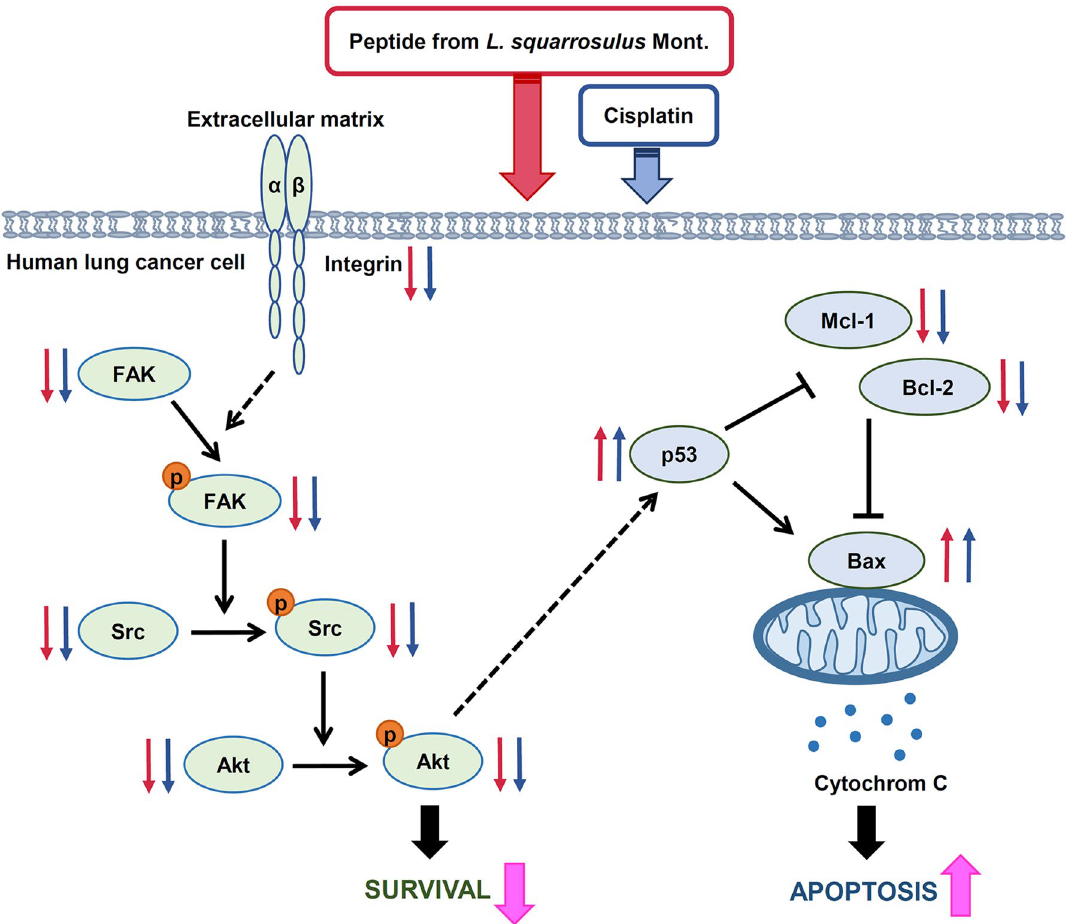
Figure 8. Proposed regulatory machinery of chemosensitizing effect of peptide extracted from Lentinus squarrosulus on cisplatin-induced apoptosis in human lung cancer cells. The peptide enhances the suppressive activity of cisplatin on integrin-mediating survival which resultes in the downregulation of integrin and down- stream signaling proteins including p-FAK/FAK, p-Src/Src and p-Akt/Akt as well as activation of apoptosis mediated by overexpression of p53 which correlates with increased Bax and diminution of anti-apoptosis Mcl-1 and Bcl-2 proteins. The effects of the peptide and cisplatin at non-toxic concentrations is indicated by red and blue small arrows, respectively. Big pink arrows represent the augmented cytotoxicity of cisplatin after pretreatment of human lung cancer cells with 0.4 M NaCl fraction of L. squarrosulus